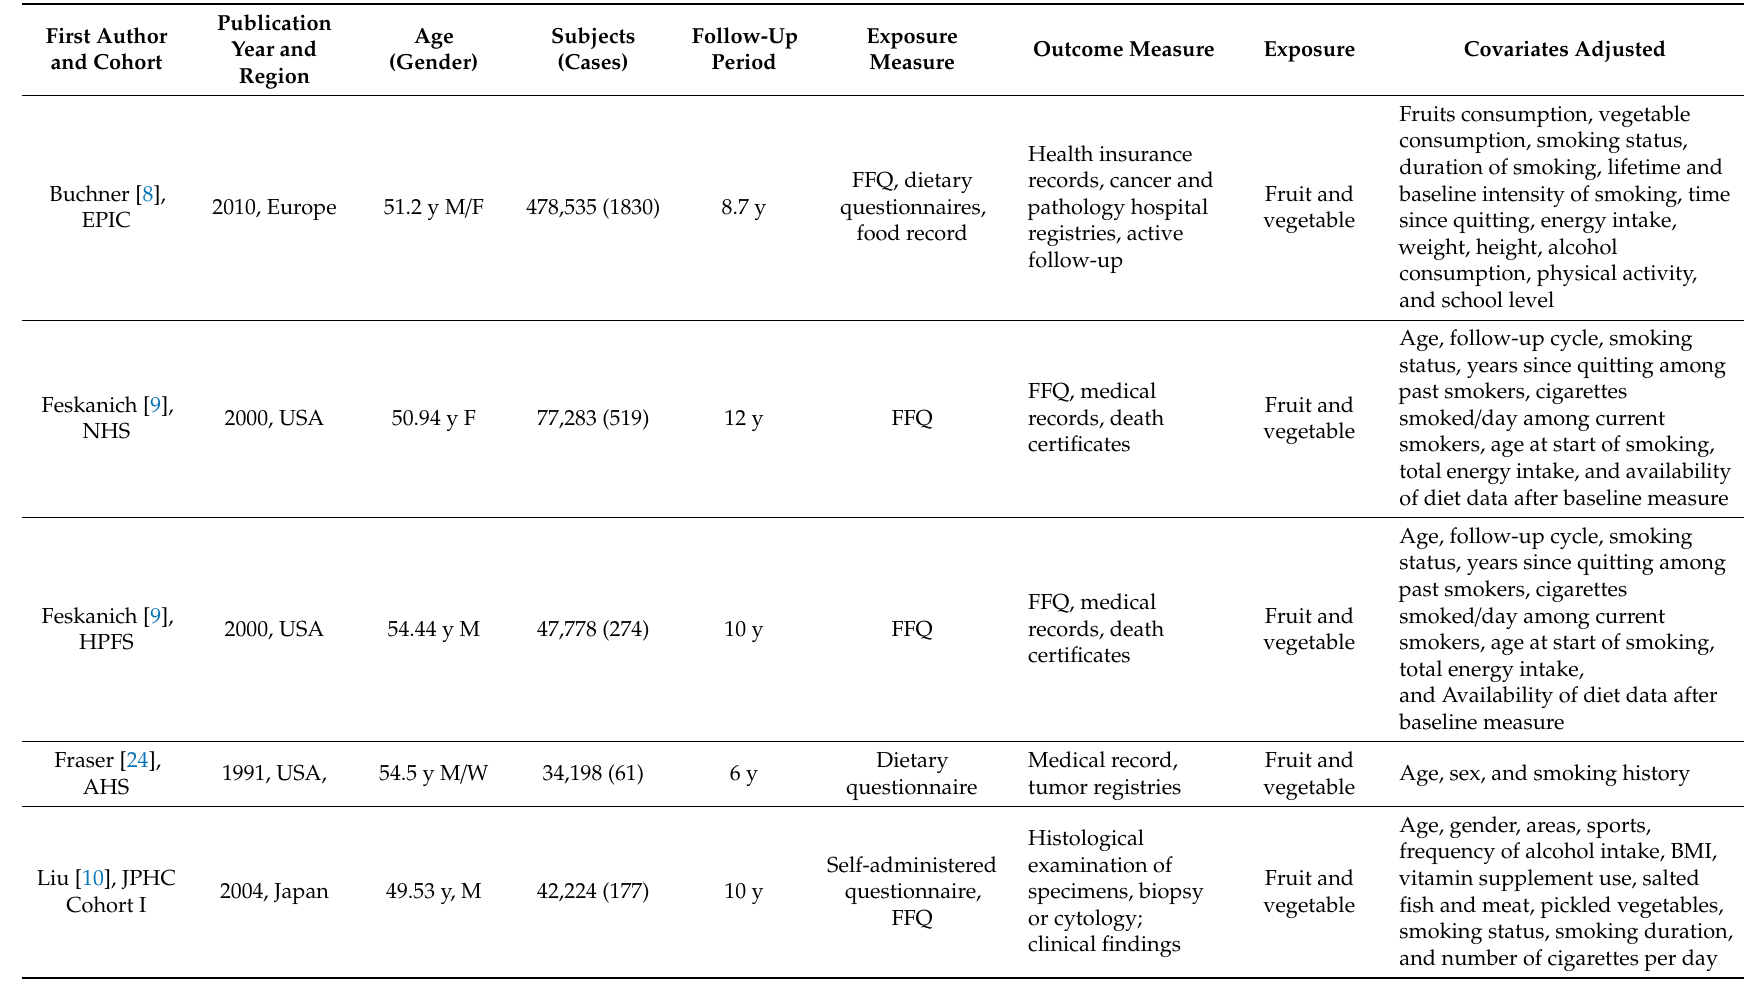
Table 1. Characteristics of included studies regarding fruit and vegetable intake and lung cancer risk 1